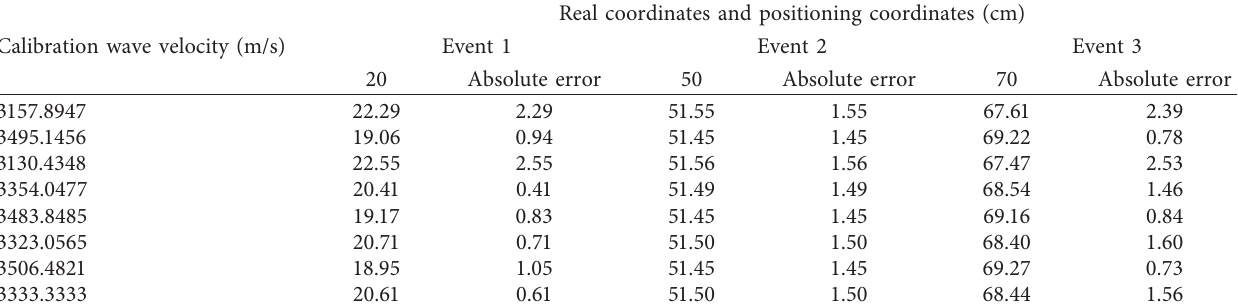
Figure 3: The sensor network layout of rod-shaped rock. Table 4: The real coordinates and positioning coordinates of line positioning at different wave velocities in G3768.